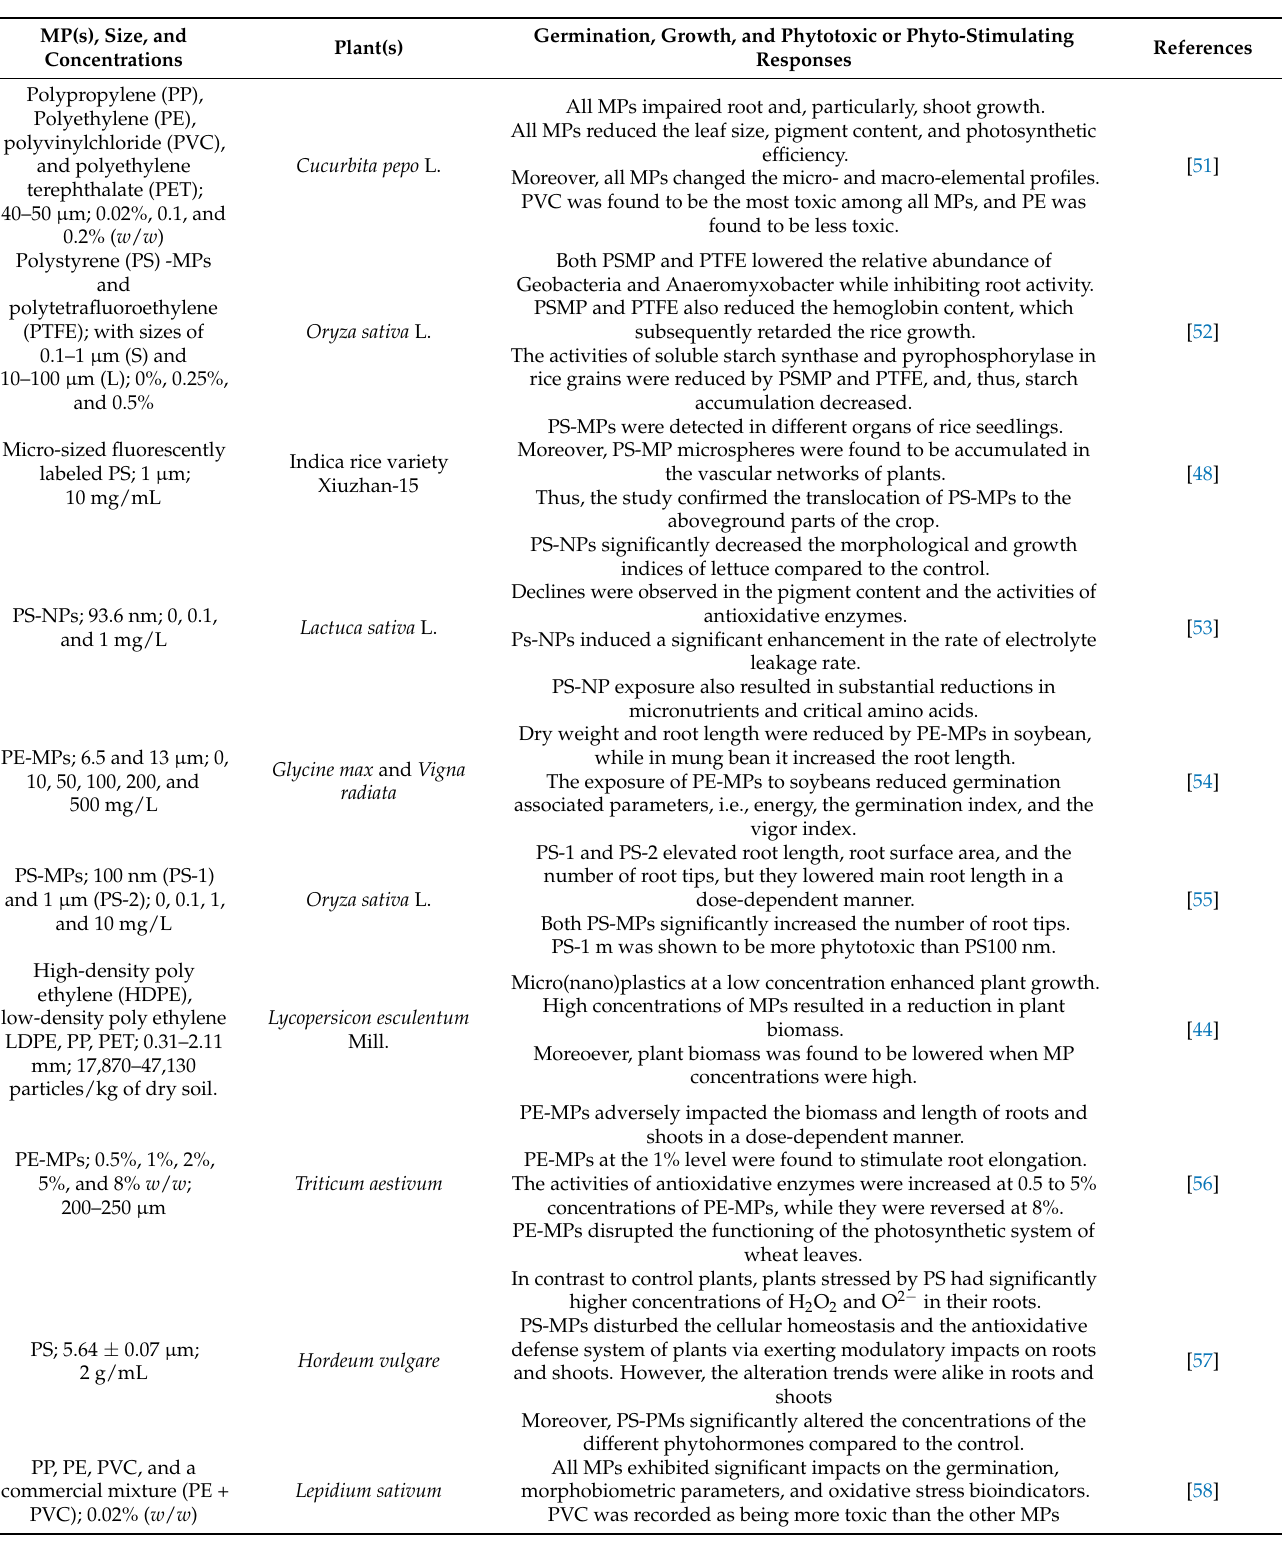
Table 1. Effects of MPs on the morpho-physiological parameters of different